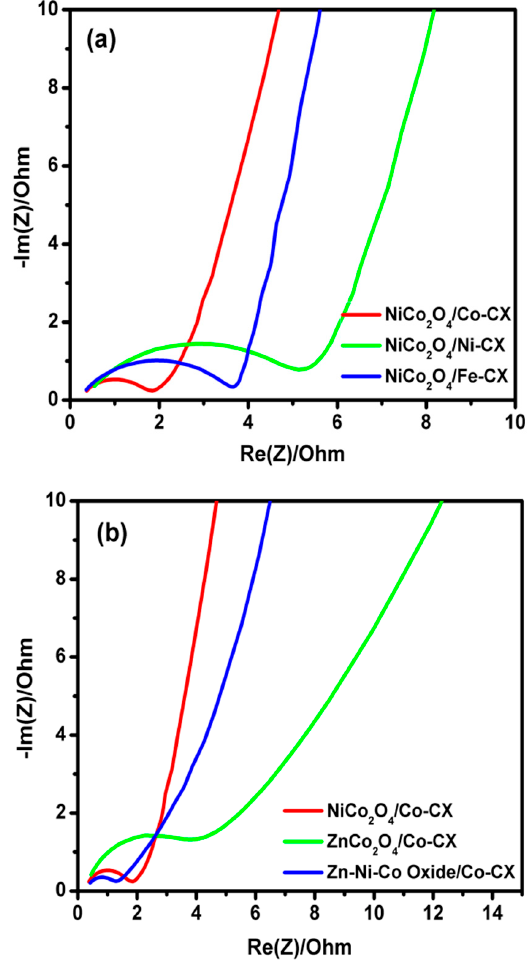
Figure 9. Nyquist plots obtained from electrochemical impedance spectroscopy (EIS) for ( a ) NiCo 2 O 4 /M ‐ CX and ( b ) NiCo 2 O 4 /Co ‐ CX, ZnCo 2 O 4 /Co ‐ CX, and Zn ‐ Ni ‐ Co oxide/Co ‐ CX.